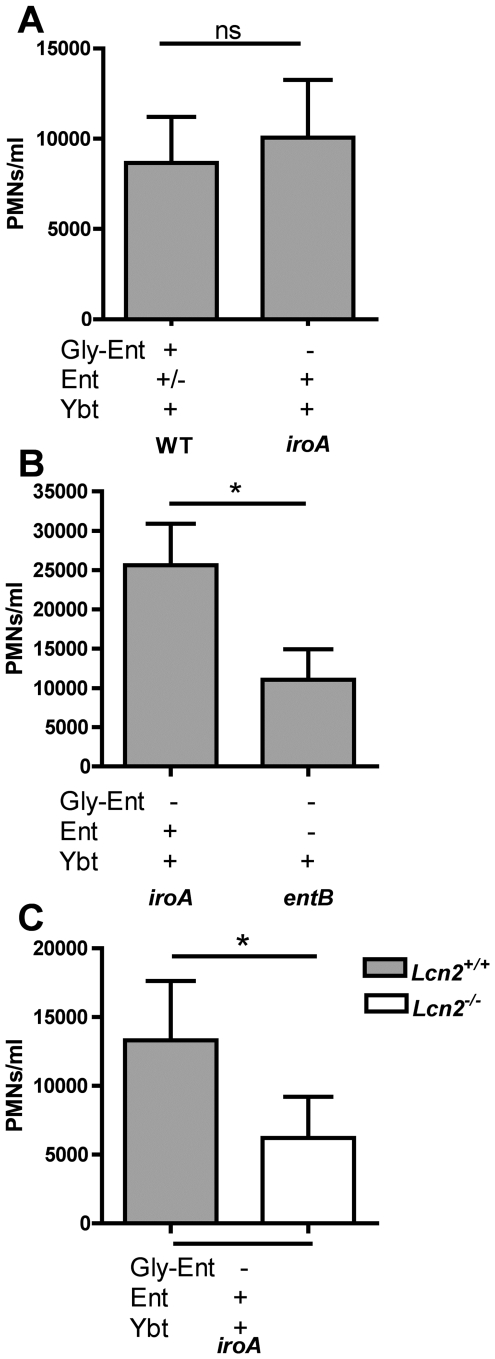
Lipocalin 2 promotes increased neutrophil influx in response to enterobactin-producing K. pneumoniae.Intraluminal neutrophil counts (PMNs) were measured by flow cytometry of 100 µL nasopharyngeal lavage fluid on day 3 after intranasal inoculation of C57BL/6 mice with 2×106 cfu of the following combinations of K. pneumoniae: wild-type KPPR1 vs. iroA mutant (A), or iroA mutant vs. entB mutant (B). *p<0.05 by the Mann-Whitney test. To determine if neutrophil influx to Ent-producing strains is Lcn2-dependent, Lcn2+/+ and Lcn2−/− littermates were colonized with 2×106 cfu of iroA mutant K. pneumoniae (C). * p<0.05 as determined by the Wilcoxon matched pair test. Data points represent CD45+, Ly6G+, CD11b+ events and dotted lines connect littermates (n≥5 per group). Siderophores encoded by each mutant are indicated by a plus (+).